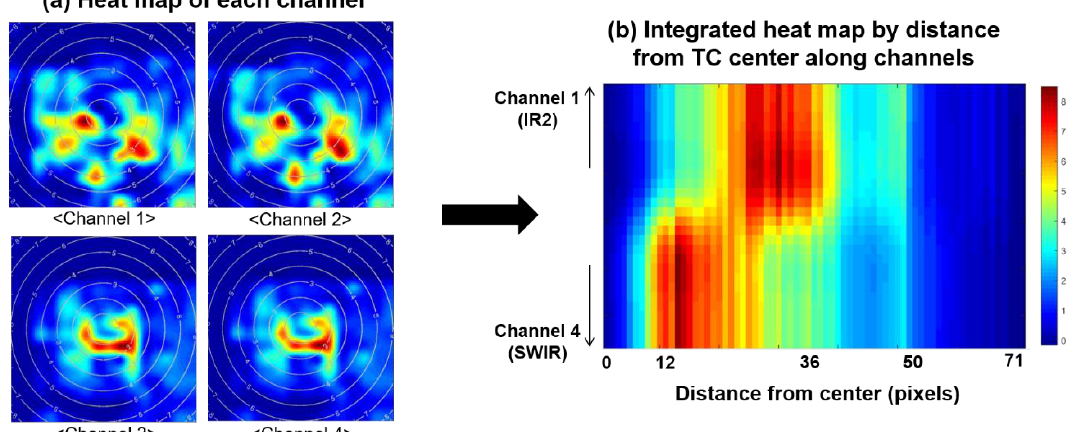
Figure 12. Four-layer heat maps and the integrated heat map using pixel distance from the TC center using Typhoon MUIFA on 05 / 06 / 2011 06:00 UTC (85 kts). ( a ) Four-layer heat maps, where the white contour lines show the distance (pixel) from the TC center. The channels 1 to 4 correspond to IR2, IR1, WV, and SWIR, respectively. ( b ) Integrated multi-dimensional heat map. The values at the same distance from the center in all layers are added in the integrated heat map (1 pixel in ( b ) corresponds to about 12 km).